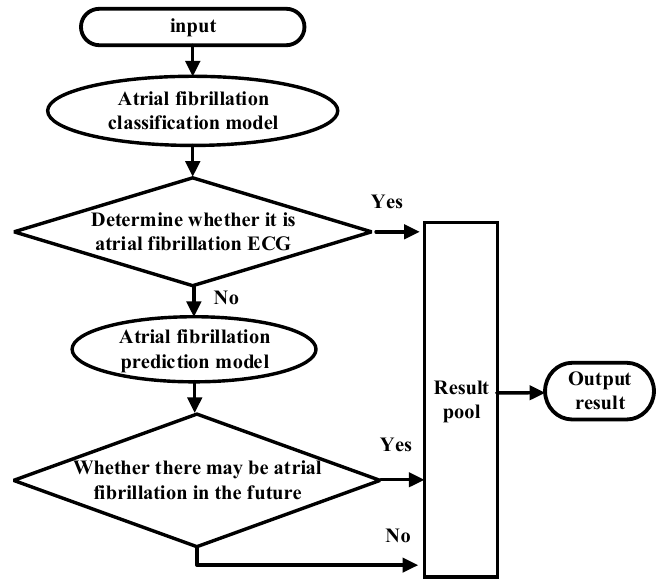
Figure 10. Flow chart of the waterfall fusion algorithm.